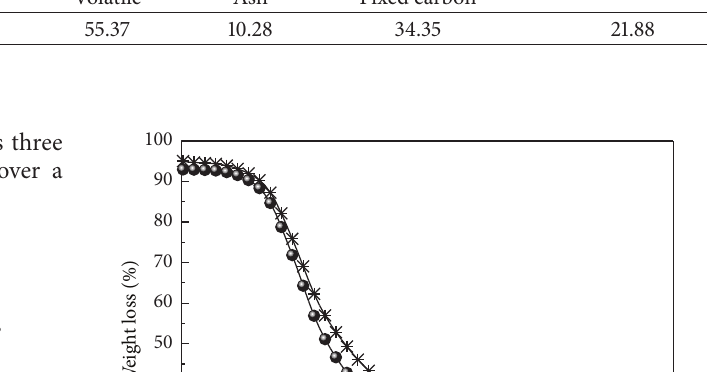
Table 1: Ultimate and proximate analysis and lower heating values of Chlorella vulgaris (on dry basis). Ultimate analysis (wt%)